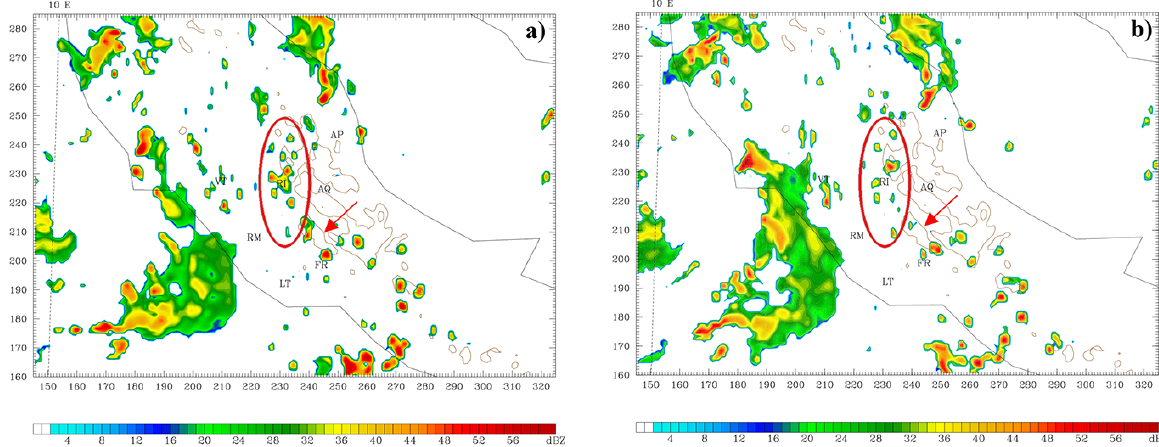
Figure 12. Reflectivity (dBZ) simulated by the ALL_2OL (a) and ALL_3OL (b) experiments with two and three outer loops, respectively, at 14:00UTC, 20 May